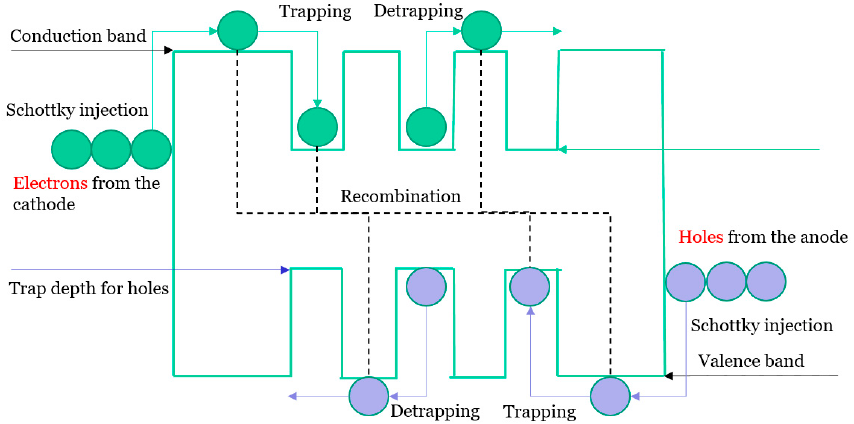
Figure 7. Schematic representation of the bipolar charge transport theory [29]. Table 1. Parameters used for simulating space charge in LDPE